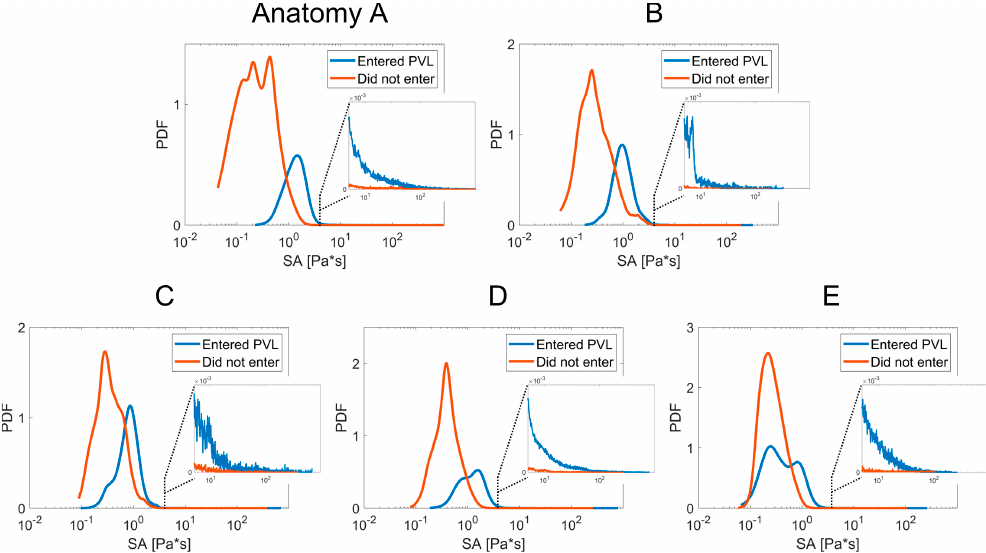
Figure 5. Probability density function (PDF) of the platelets stress accumulation (SA) comparison — Showing the increased stress accumulation of platelets entering the PVL channels (blue peaks shifted right). Inset graph highlights higher stress values (>5 Pa*s). Each PDF represents the patient-specific anatomies ( A – E ).